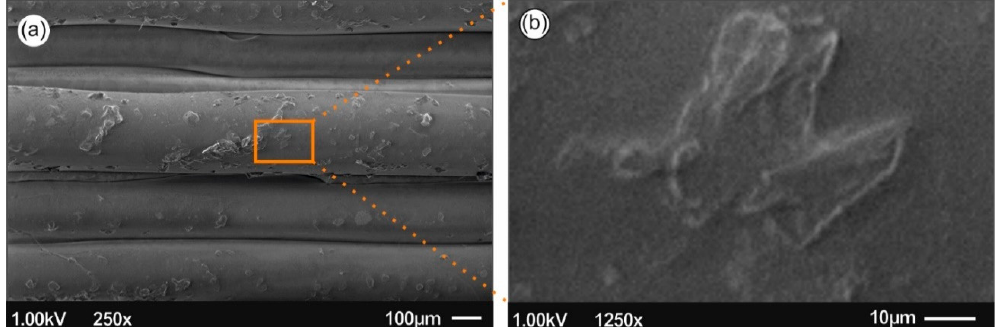
Figure 7. Scanning electron microscopy (SEM) images of the side-surface microstructure and morphology for the different 3D printed samples in this study at two different magnifications (all 3D printed samples with 300 µm printed layer thickness): Neat PLA SEM image at 250× magnification ( a ) and 1250× magnification ( b ), respectively.